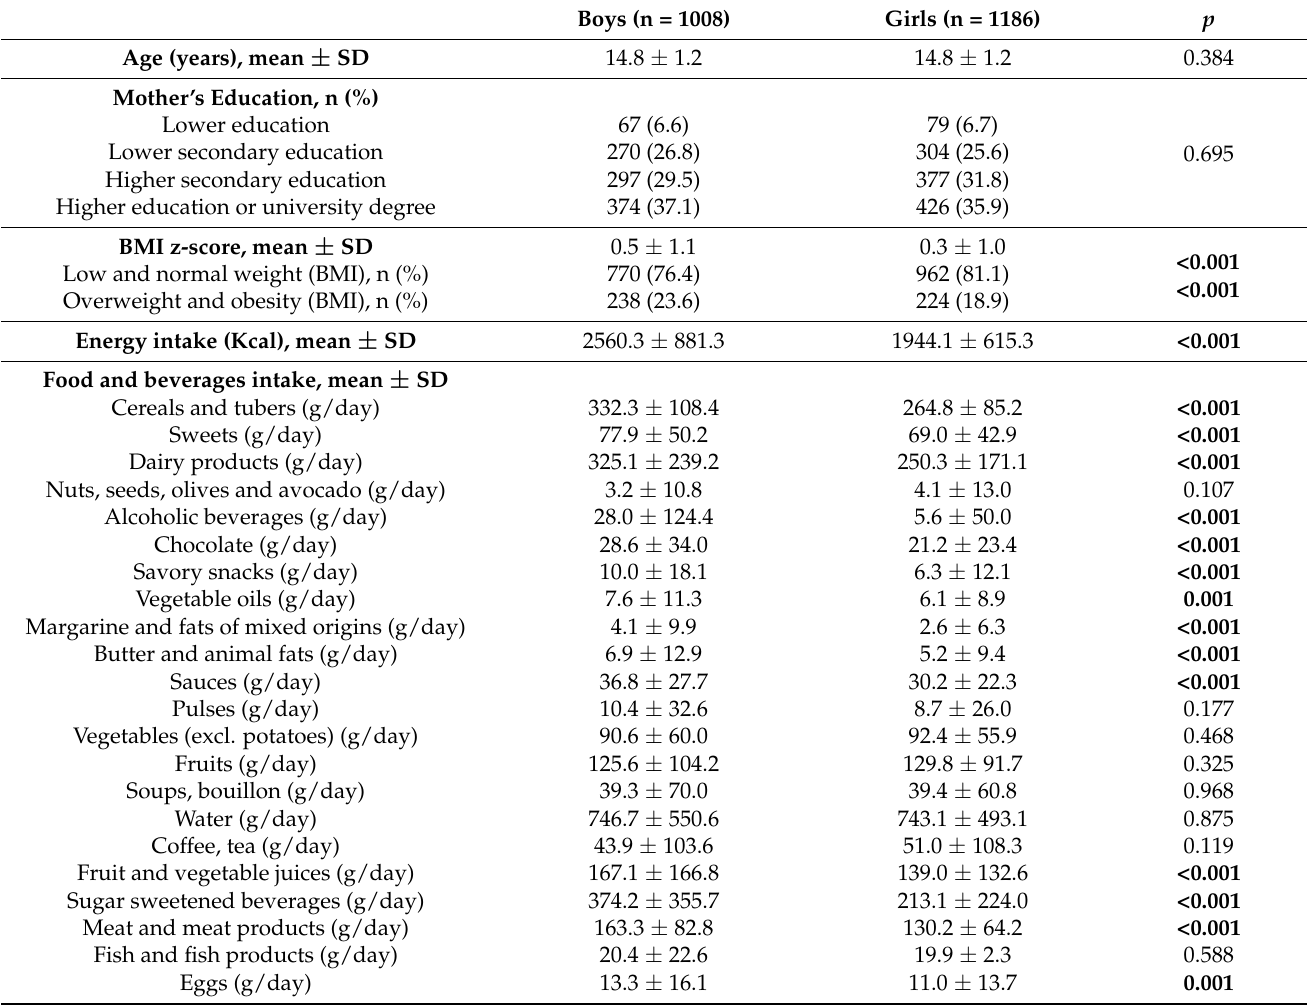
Table 1. Descriptive characteristics of the European adolescent sample from the HELENA study (n =